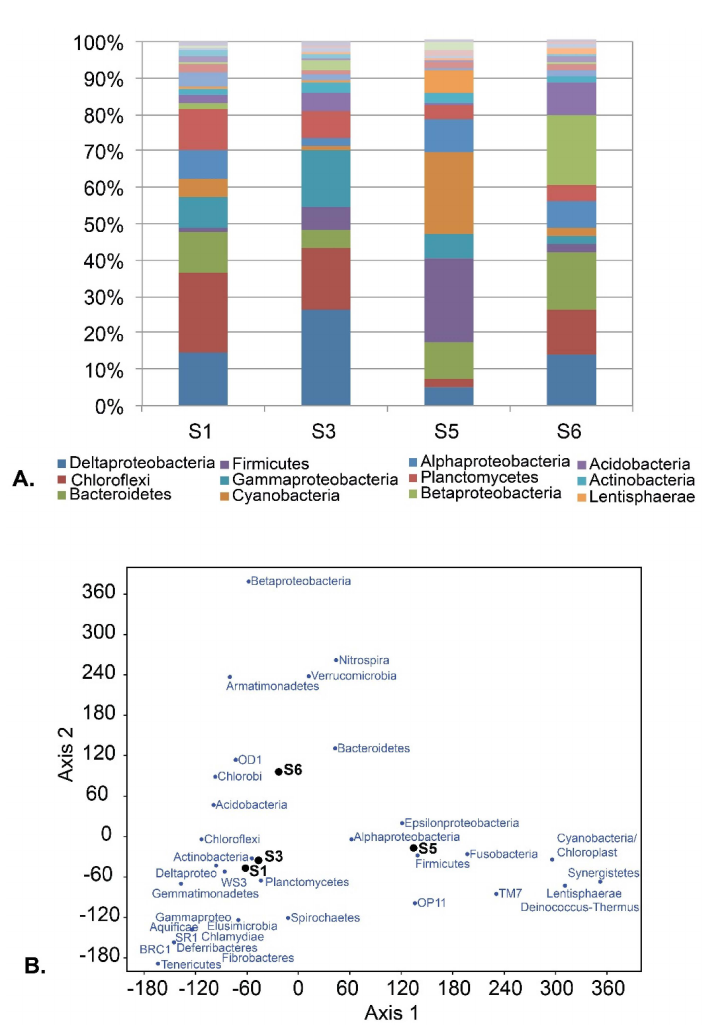
Figure 7. ( A ) Bar chart illustrating the diversity of bacterial sequences from four Guánica Bay sediment samples based on 454 pyrosequencing. Samples S1 and S3 are characterized by large numbers of Chloroflexi bacteria with affiliations to known PCB degrading strains. Shoreline sediment sample S5 is characterized by increased abundance of Firmicutes and Cyanobacteria. ( B ) Detrended Correspondence Analysis (DCA) showing the relative similarity of the microbiomes from the four sediment samples and the relative loadings of bacterial phyla.